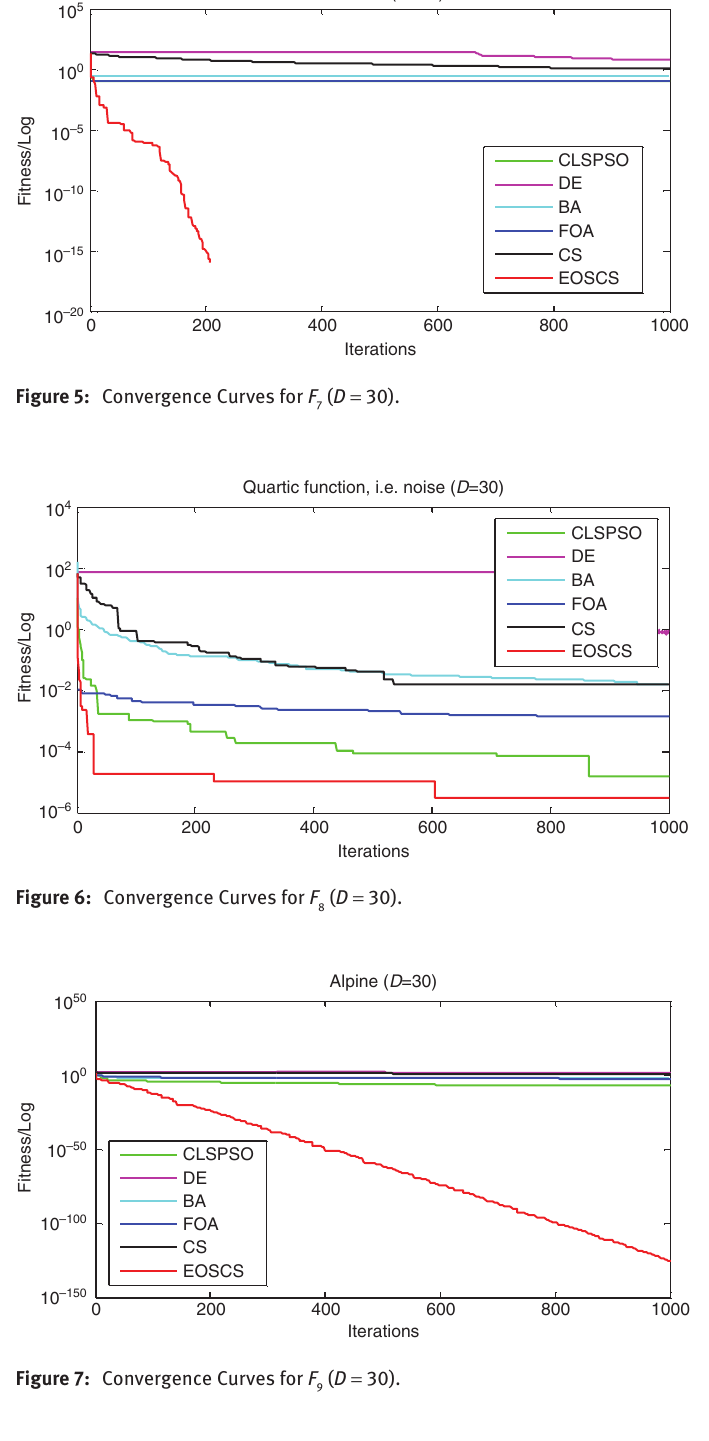
Figure 7: Convergence Curves for F